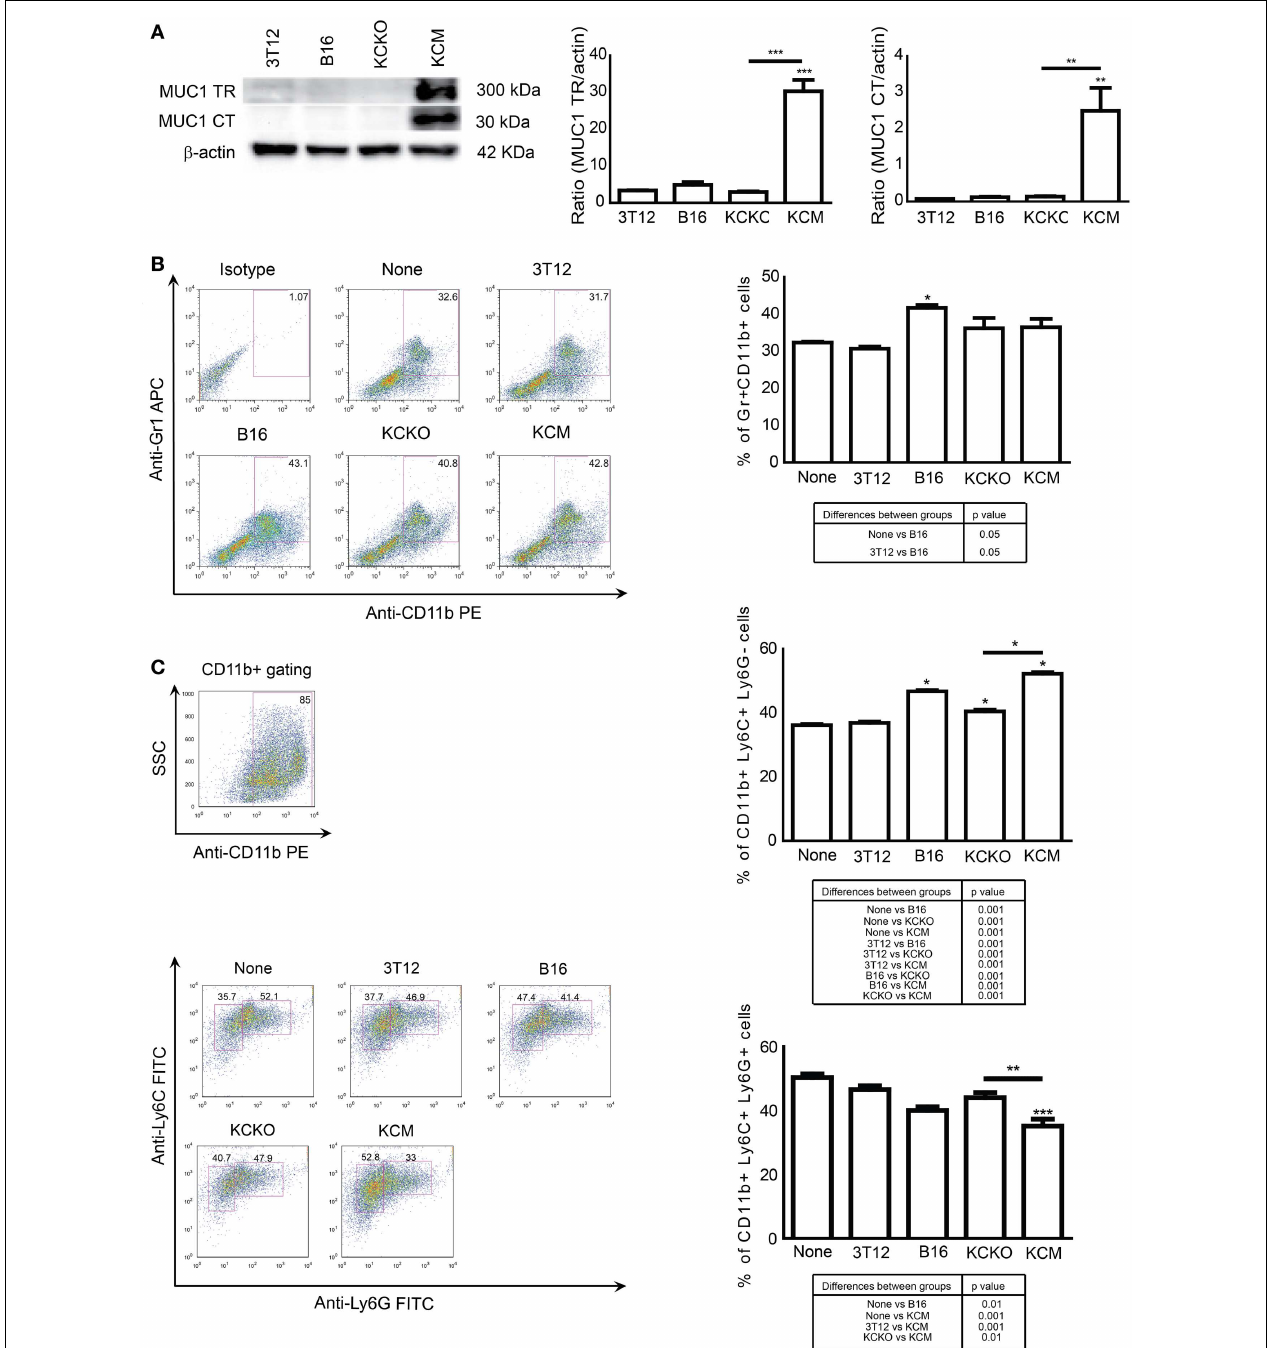
Western blotting for MUC1 and β -actin protein expression was carried out three times; (B) Representative dot plot and graph of percent Gr1 + CD11b + cells; (C) Representative dot plot and graph of percent CD11b + Ly6C + LyG − and CD11b + Ly6C + Ly6G + cells.The MDSC subsets were obtained by gating on CD11b + cells as indicated (top left plot). Percentages are not absolute numbers. Mean and standard error are plotted. * p < 0.5, ** p < 0.01, and *** p < 0.001 for statistically significant differences from control (3T12) levels unless indicated by the line above the bars. A table of statistically significant differences between each group is provided below dot